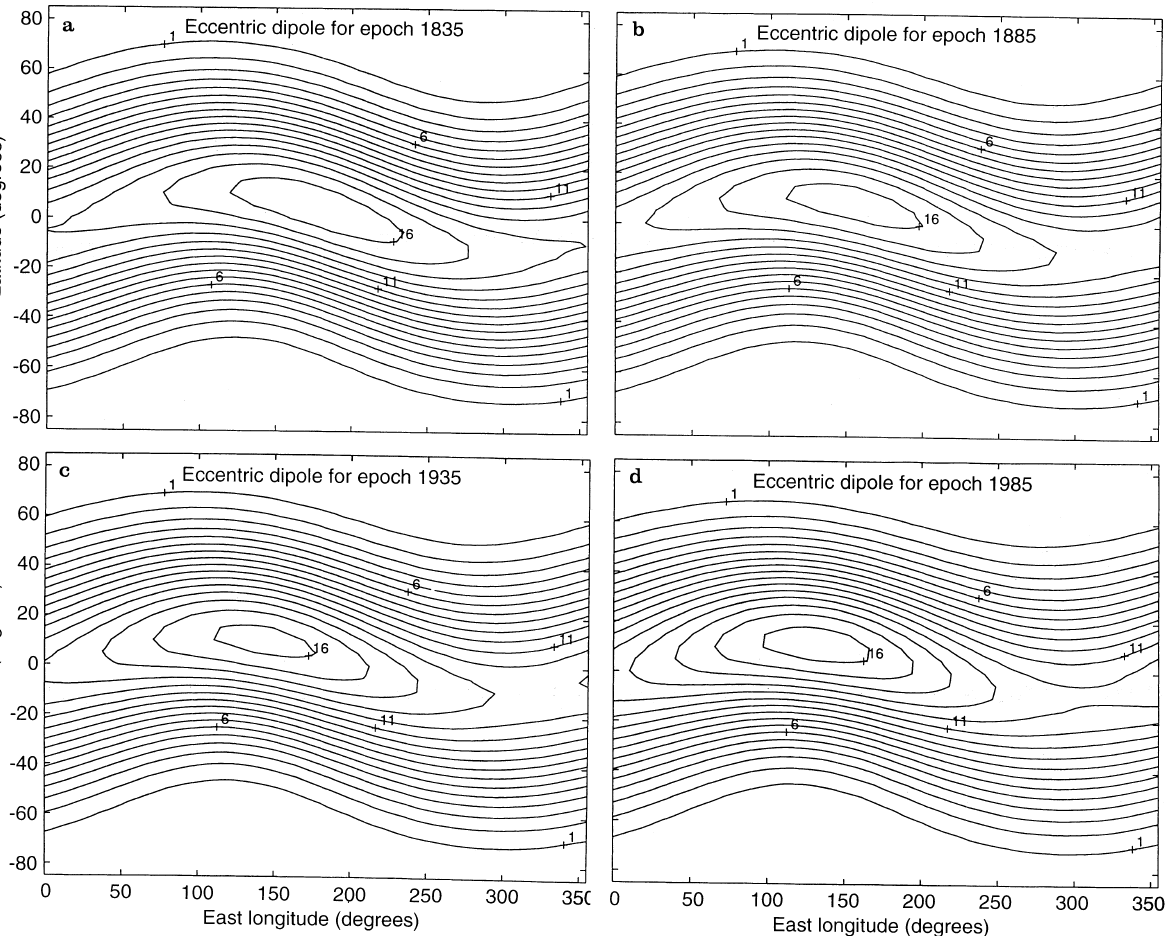
Fig. 3a–d. Isorigidity contours of vertical cosmic ray cuto(cid:128) rigidities (in GV), at an altitude of 100 km, computed in the geomagnetic field approximated by an eccentric dipole, for epochs 1835, 1885, 1935, and